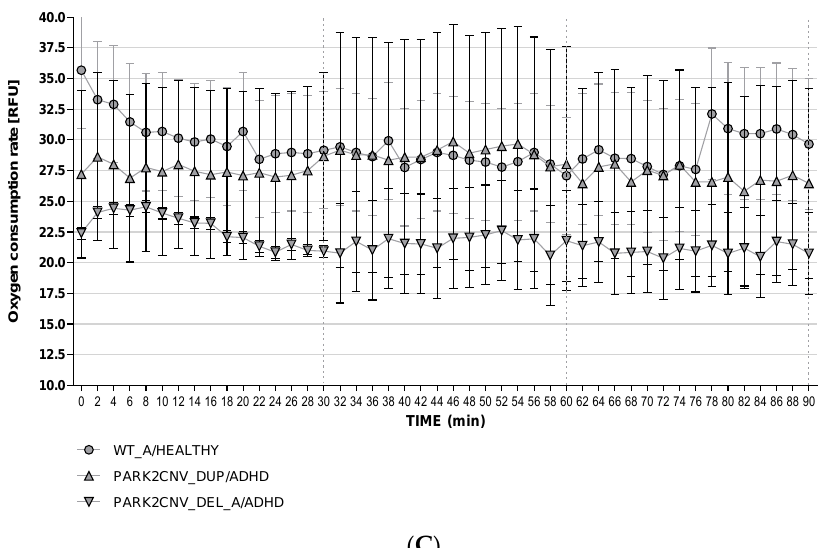
Figure 5. ( A – C ): Oxygen consumption rate in mDAN. Basal oxygen consumption rate was evaluated both under baseline ( A ), starvation ( B ), and CCCP treatment conditions ( C ). Fluorescence (RFU- y -axis) signal correlating with the respiration was recorded every two minutes for 90 min. Data are presented as mean of two independent experiments with samples measured in triplicates. Because the biological replicates were n = 1 for each group, the data shown here are only descriptive.